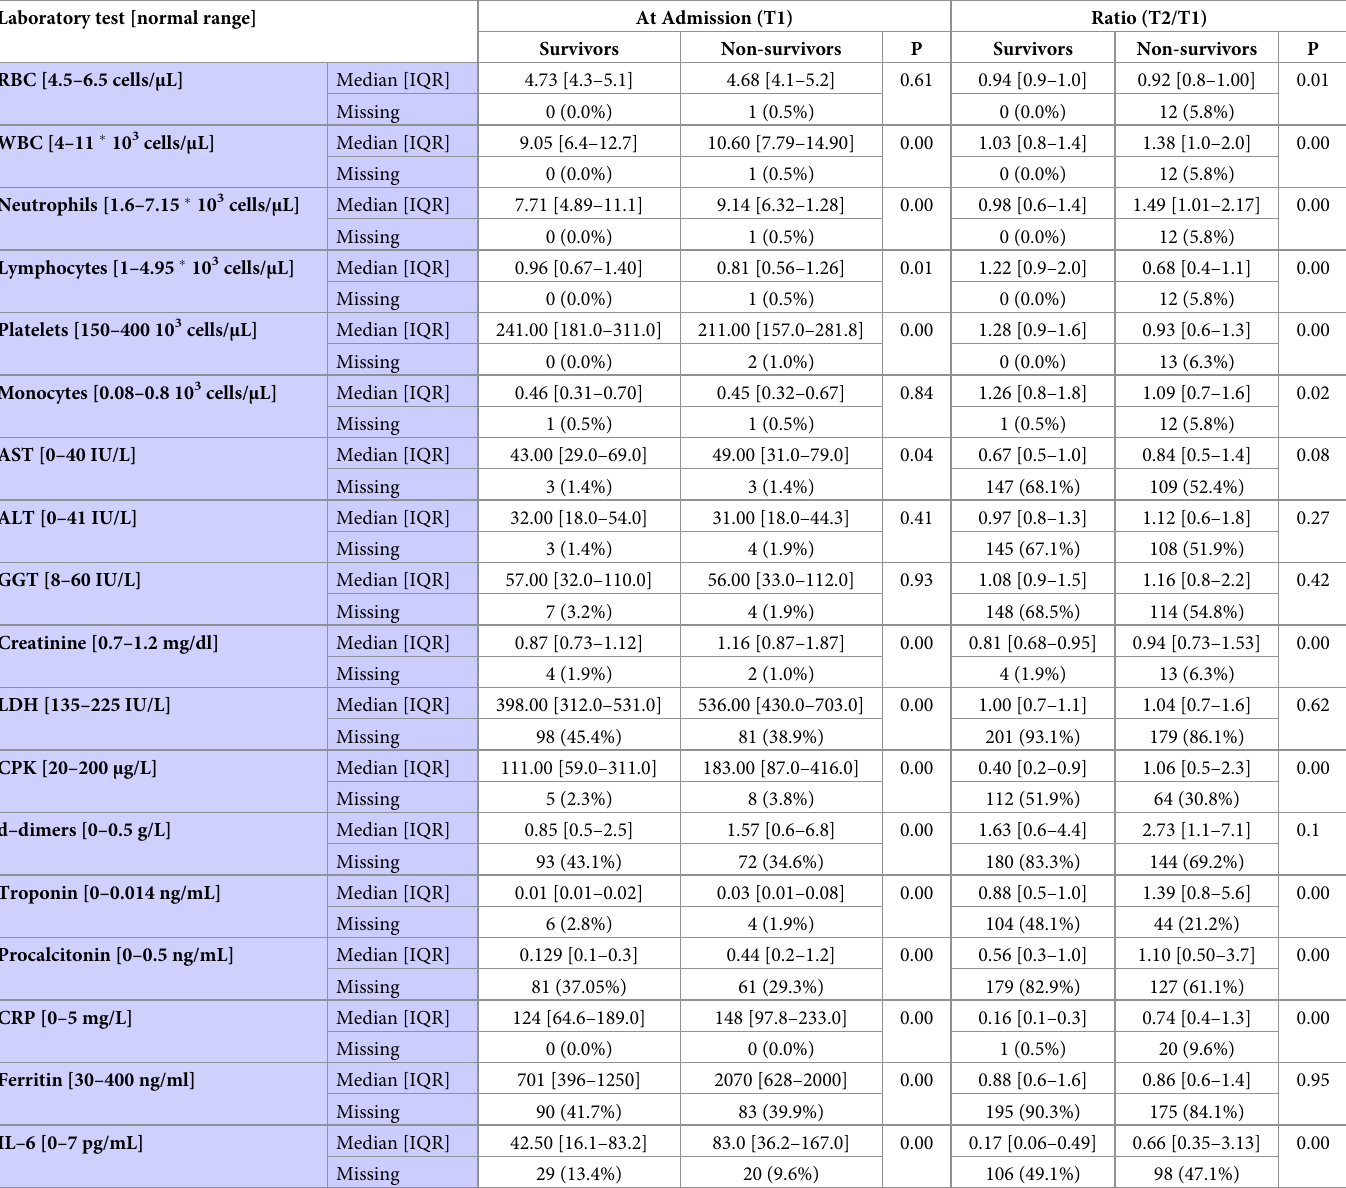
Table 5. Comparison of laboratory results between alive and death groups (LINE